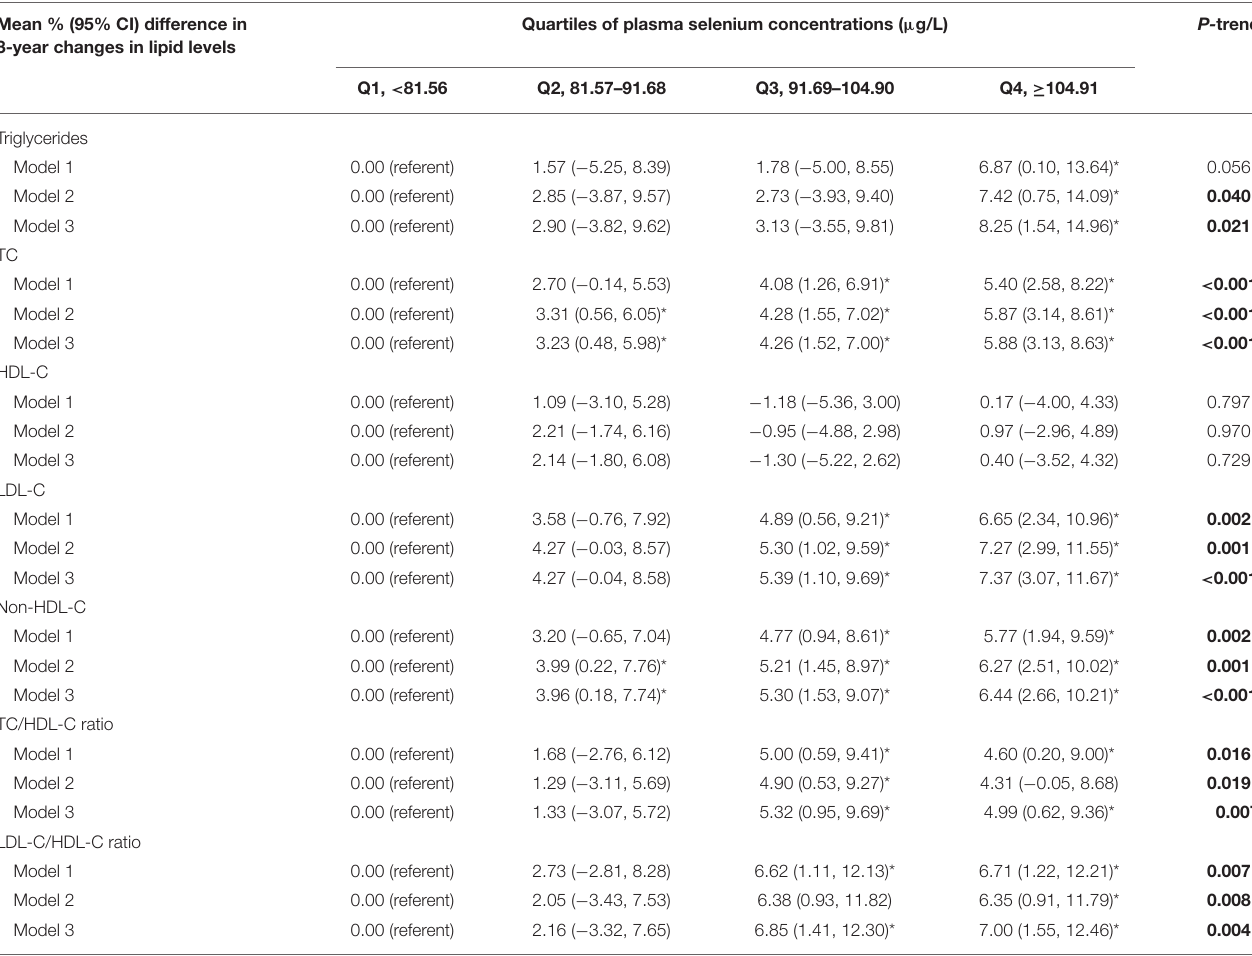
Quartiles of plasma selenium concentrations ( µ